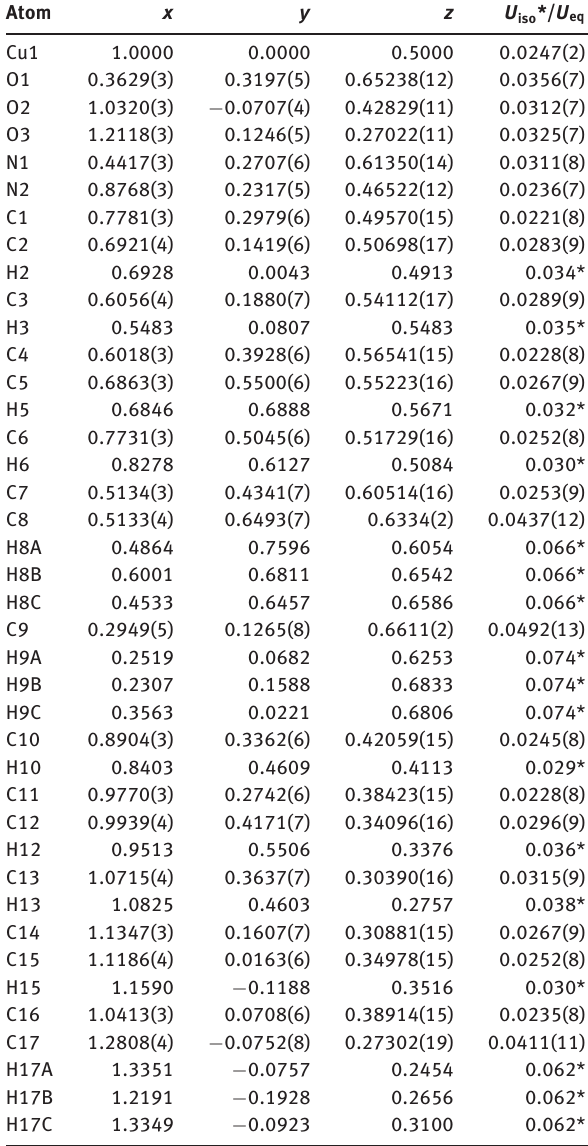
Table 2: Fractional atomic coordinates and isotropic or equivalent isotropic displacement parameters (Å 2